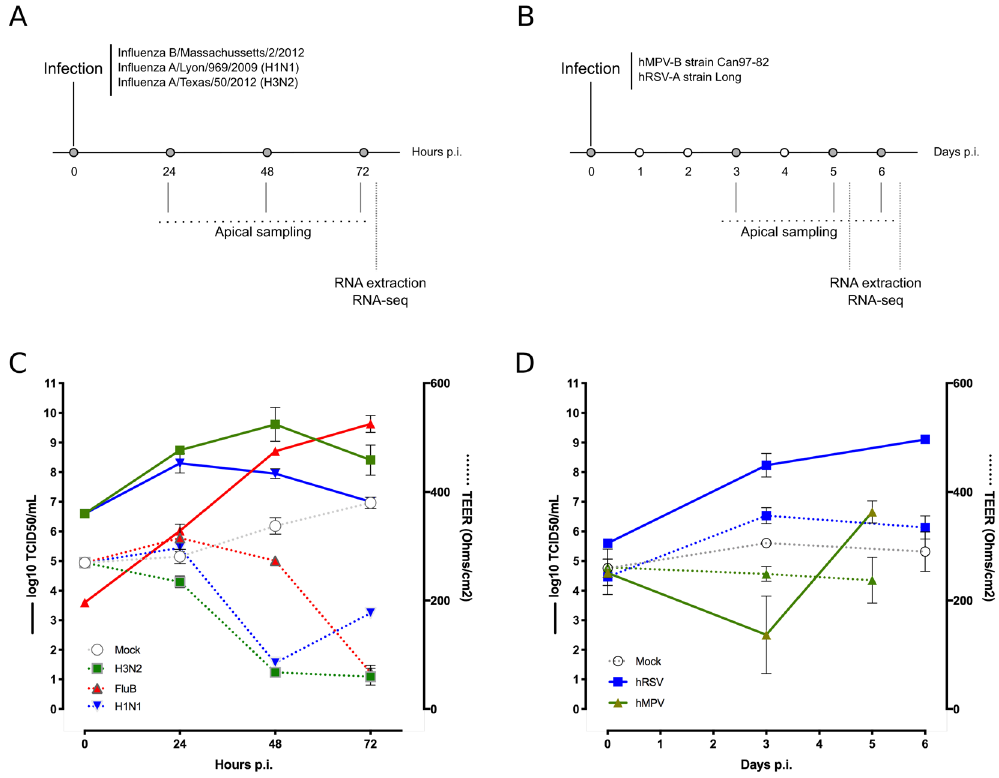
Figure 1. Viral infection in HAE: experimental protocol and biological monitoring results. ( A , B ) Apical poles were gently washed with 200 µ L of OptiMEM medium. 150 µ L of diluted viruses (Influenza B/ Massachussets/2/2012, Influenza A/Lyon/969/2009, Influenza A/Texas/50/2012 in panel A and hMPV-B strain CAN97-82 or hRSV-A strain Long in panel (B) were added to the apical pole and incubated for 1 h at 37 °C. The infection is mimicked in the mock condition by adding virus-free OptiMEM medium. The viral suspension was then removed and apical poles were washed with OptiMEM. The OptiMEM medium was removed and air- liquid interface was restored. Kinetic samplings and measures were performed at the specified timing and after the last sampling, cells were lysed in RLT buffer and stocked at − 80 °C before RNA extraction. ( C , D ) Membrane resistance between the apical and basal pole was measured at each time-point. The resulting trans-epithelial resistance (TEER in Ohms/cm 2 ) is represented in dotted line and color-coded in accordance with infectious condition (mock in white, H3N2 in green, influenza B in red and H1N1 in blue in panel C and blue for hRSV and green for hMPV-B in panel D). Viral production at the apical pole was assessed after apical medium collection at the indicated time-points: 24-48-72hpi for influenza viruses and 3dpi and 5 or 6dpi for hRSV and hMPV. Viral titers indicated at T = 0 in correspond to the input viral load as validated by back-titration. For each time-point, MDCK (influenza virus) or LLC-MK2 cells (hRSV/hMPV) were incubated with serial dilutions from collected sample for the determination of viral titers. The specific parameters (infection protocol, MOI, time-points) previously optimized allow a precious and precise infection monitoring with appropriate viral replication (increasing titers) and a dropping mobility capacity of